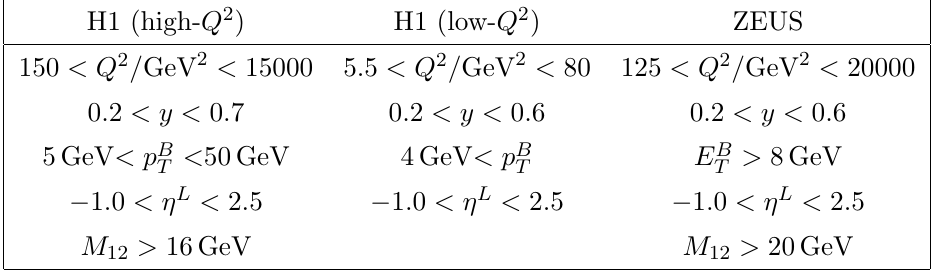
Table 7 . Kinematical cuts used to de(cid:12)ne the inclusive di-jet phase space in the measurements of H1 (high- Q 2 [11] and low- Q 2 [12]) and ZEUS